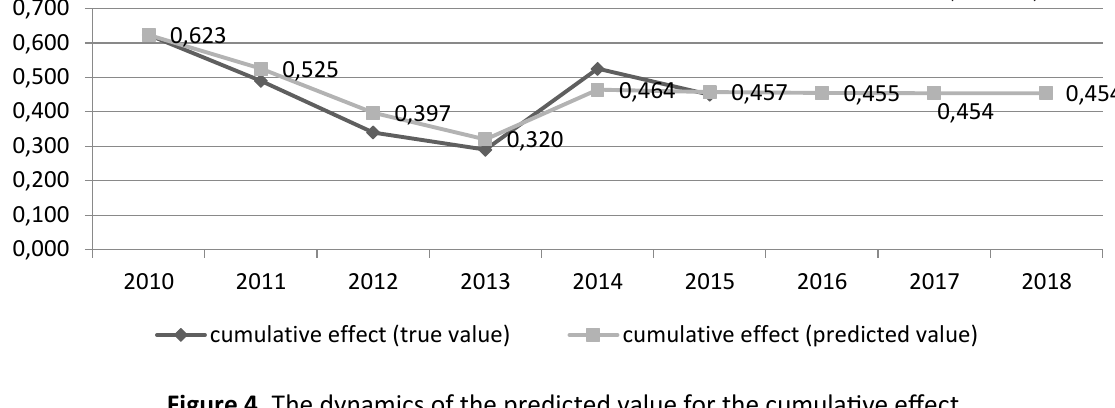
Figure 4. The dynamics of the predicted value for the cumulative effect at PJSC “Kremenchug Wheel Plant”